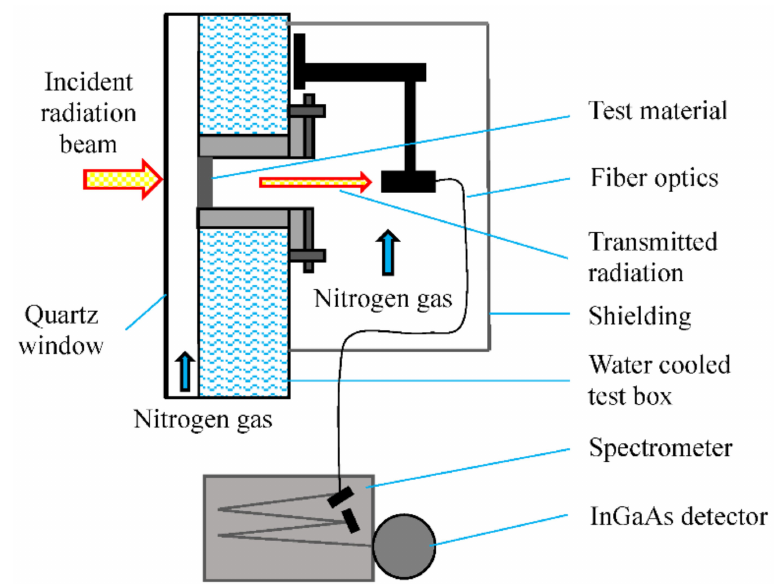
Figure 11. Schematic diagram of transmission spectrum measuring system based on solar radiation